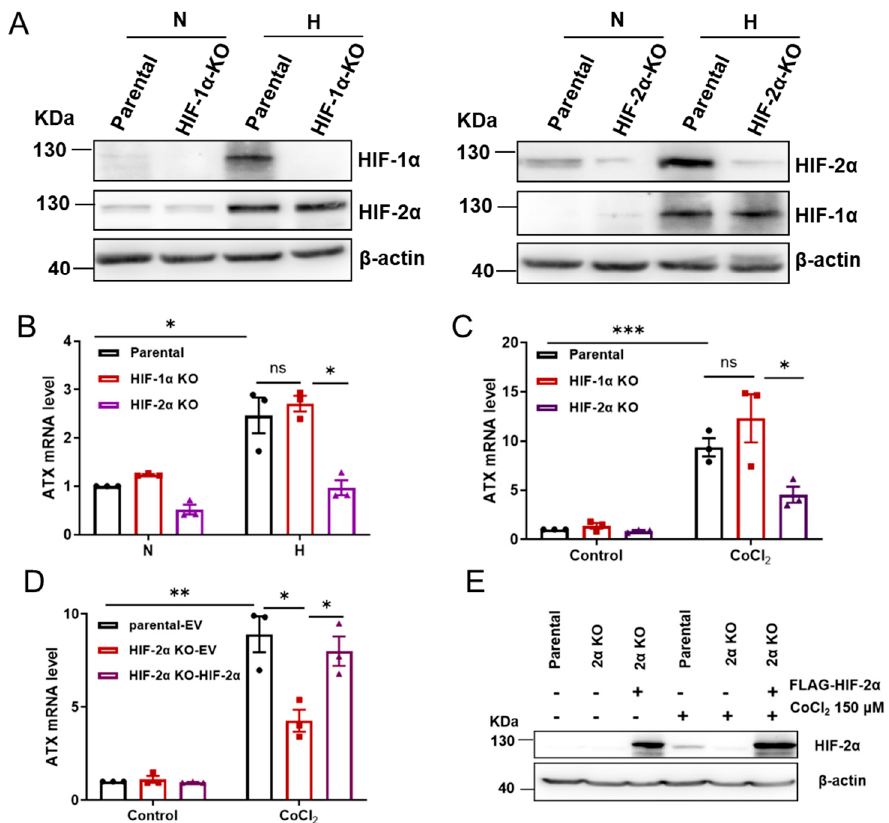
Figure 3. The hypoxic induction of ATX is HIF-2 α dependent. ( A ) Immunoblot assays of HIF-1 α and HIF-2 α expression levels in parental, HIF-1 α –KO, and HIF-2 α –KO SW480 cells exposed to normoxia (N) or hypoxia (1% O 2 , H) for 24 h. ( B ) RT ‒ qPCR analysis of ATX mRNA levels in parental, HIF-1 α –KO, and HIF-2 α –KO SW480 cells exposed to normoxia (N) or hypoxia (1% O 2 , H) for 24 h. ( C ) RT ‒ qPCR analysis of ATX mRNA levels in parental, HIF-1 α –KO, and HIF-2 α –KO SW480 cells treated with or without CoCl 2 (150 µM) for 24 h. ( D , E ) SW480 cells transfected with FLAG-vector or FLAG-